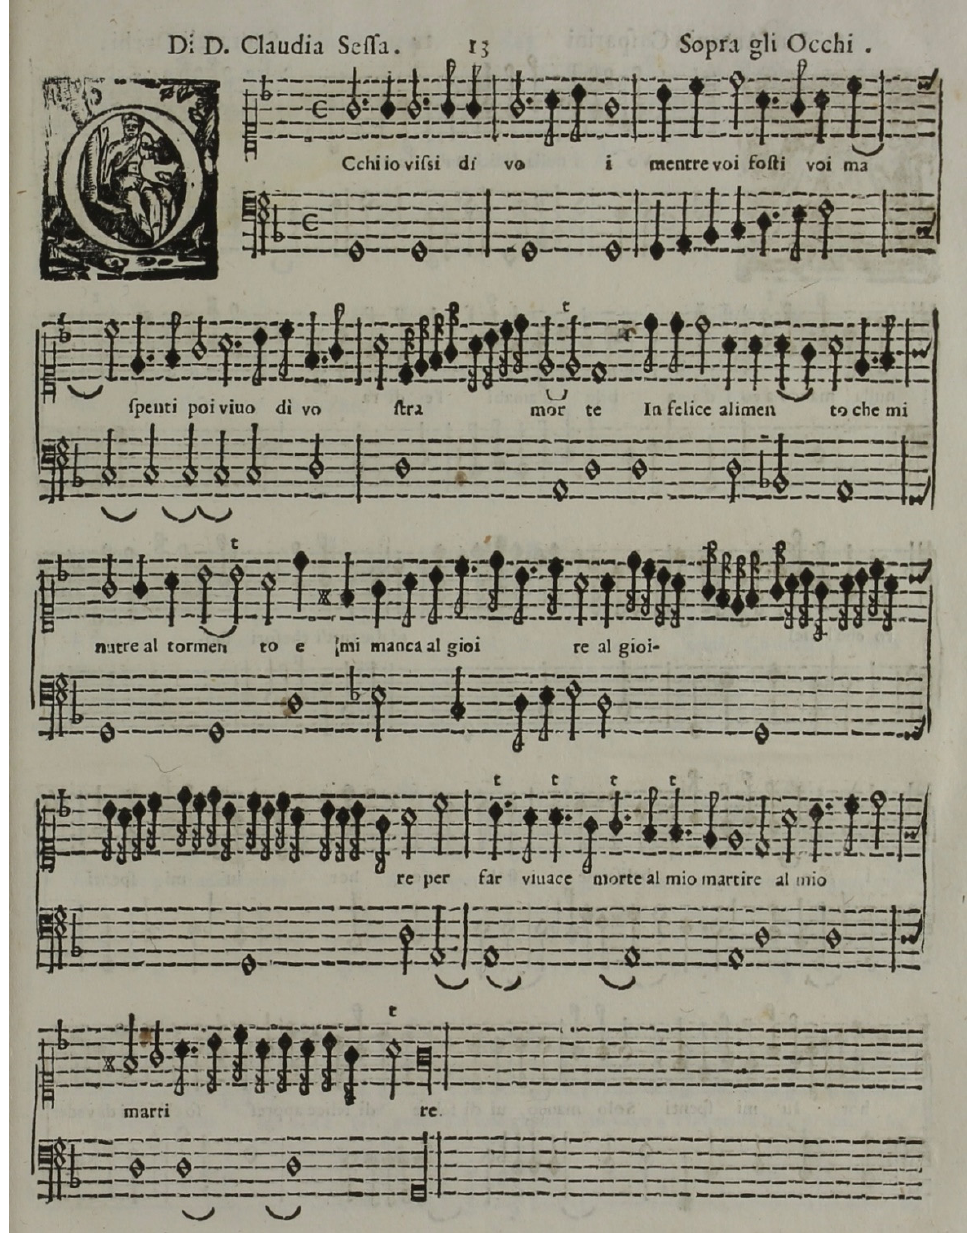
Figure 1. Claudia Sessa, Occhi io vissi di voi (Magni 1613, p. 13), by permission of the